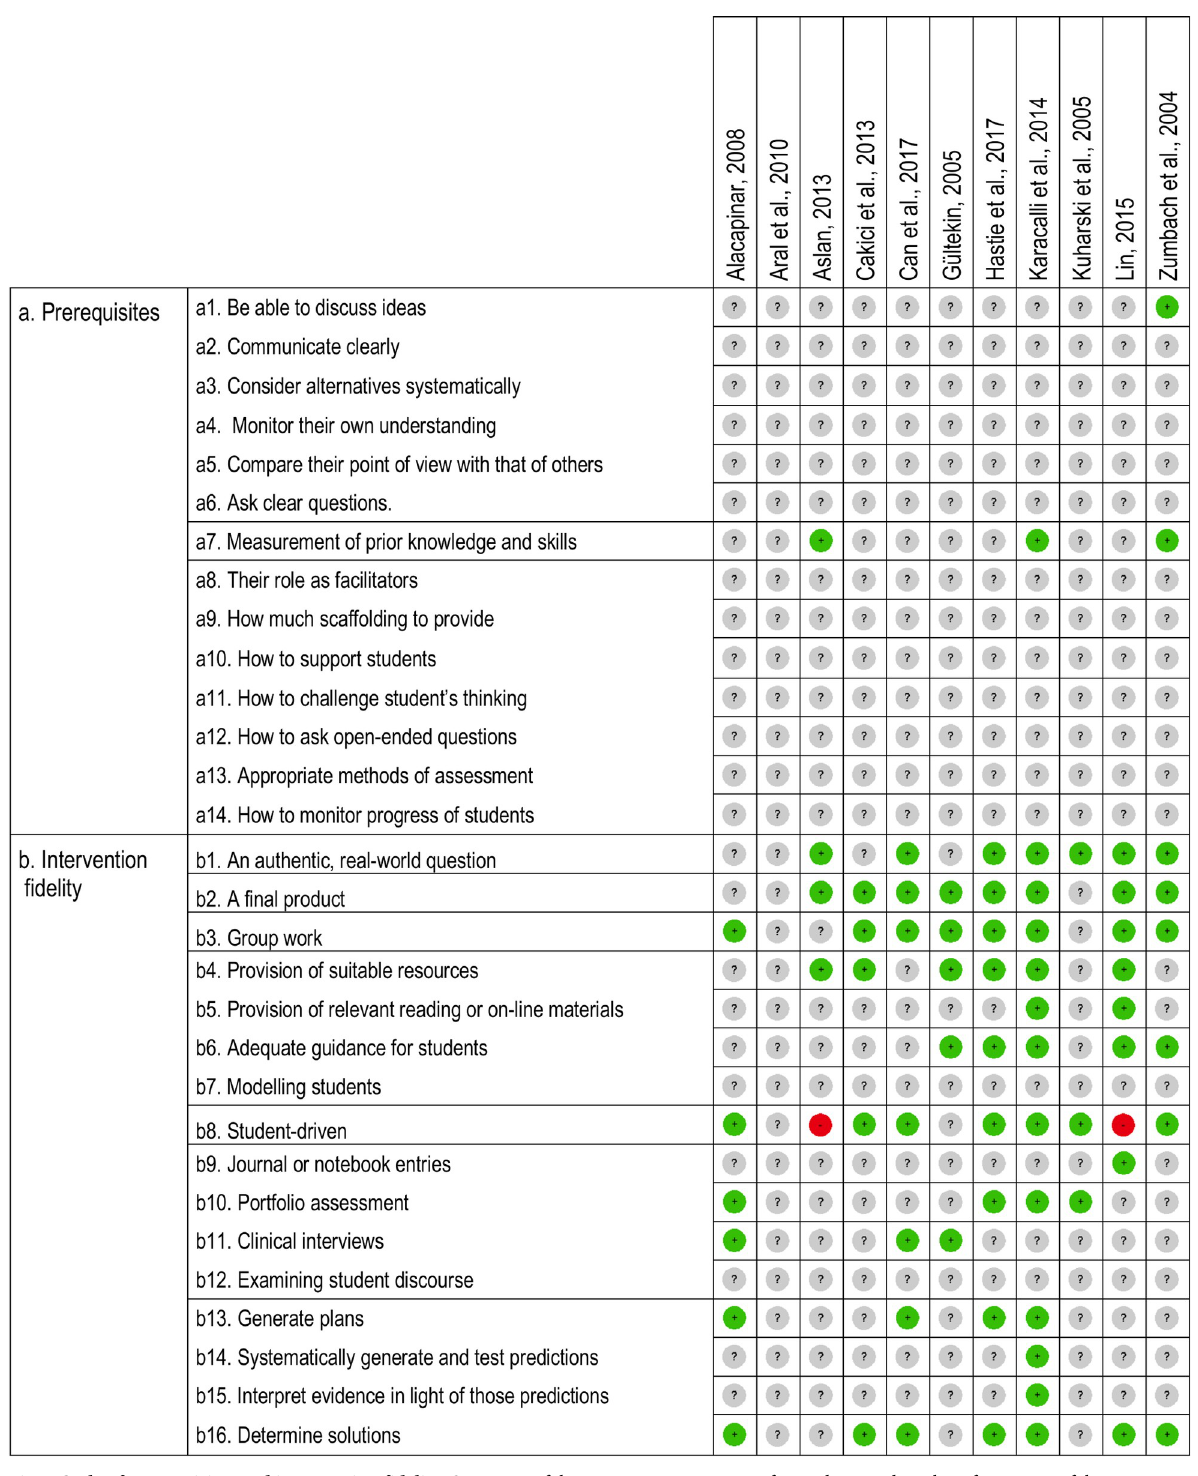
PLOS ONE | https://doi.org/10.1371/journal.pone.0249627 April 2,